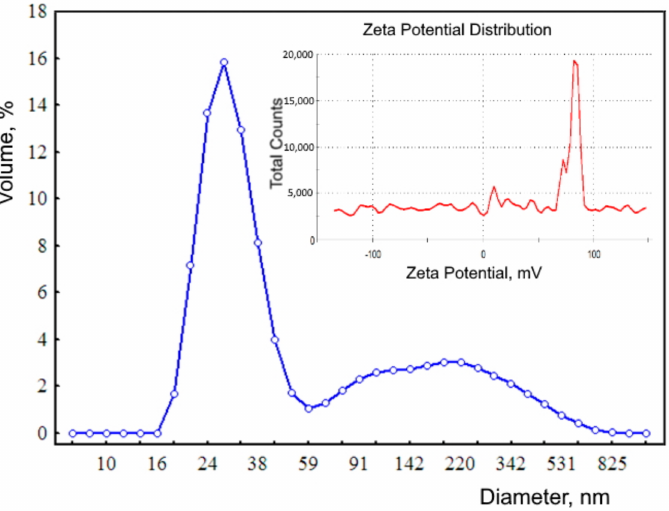
Figure 2. Distribution of the hydrodynamic diameter of biogenic ferrihydrite (blue line). Inset: zeta potential distribution (red